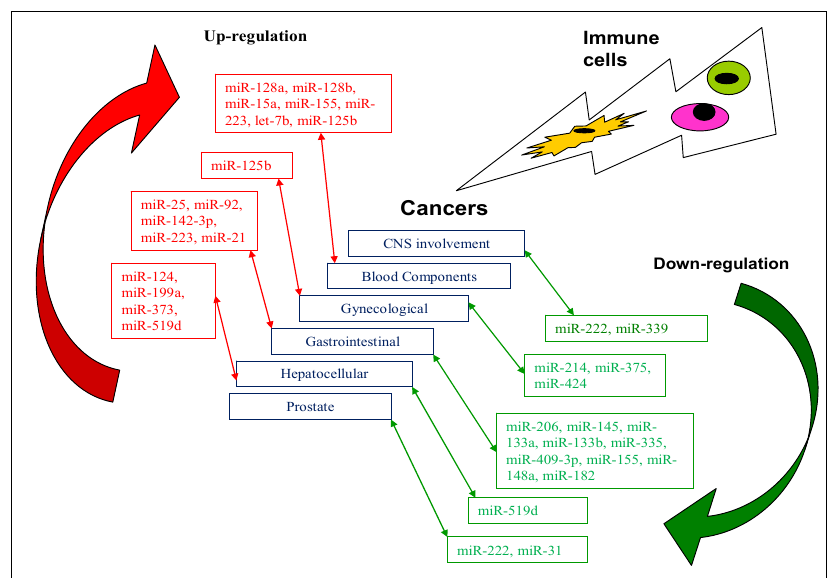
Figure 2. Tumour types and their miRNA